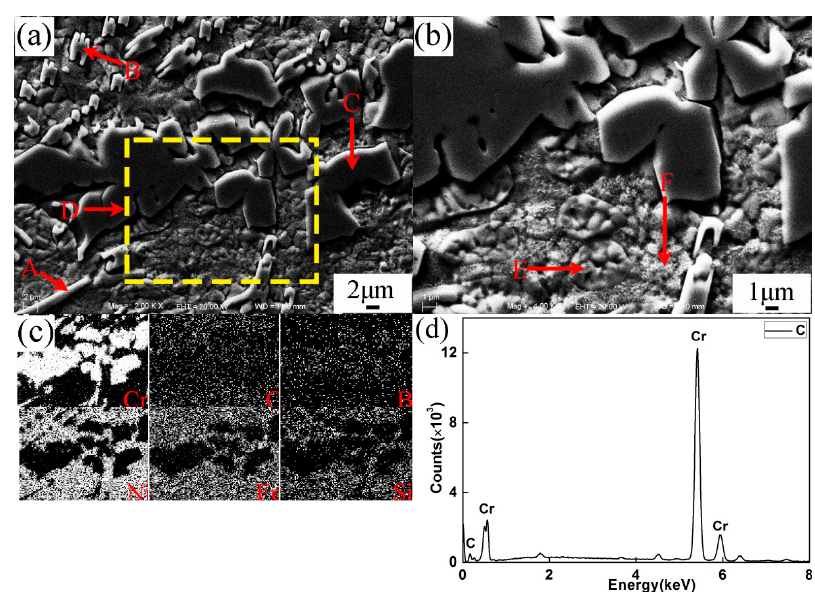
Figure 4. SEM and EDS of coating of specimen No. 1. ( a ) Microstructures of the coating for specimen No.1 (SEM); ( b ) Magnification of D zone; ( c ) The chemical elements in specimen No.1; ( d ) EDS of location C. Table 5. EDS results of different points in Figure 4a (at %).